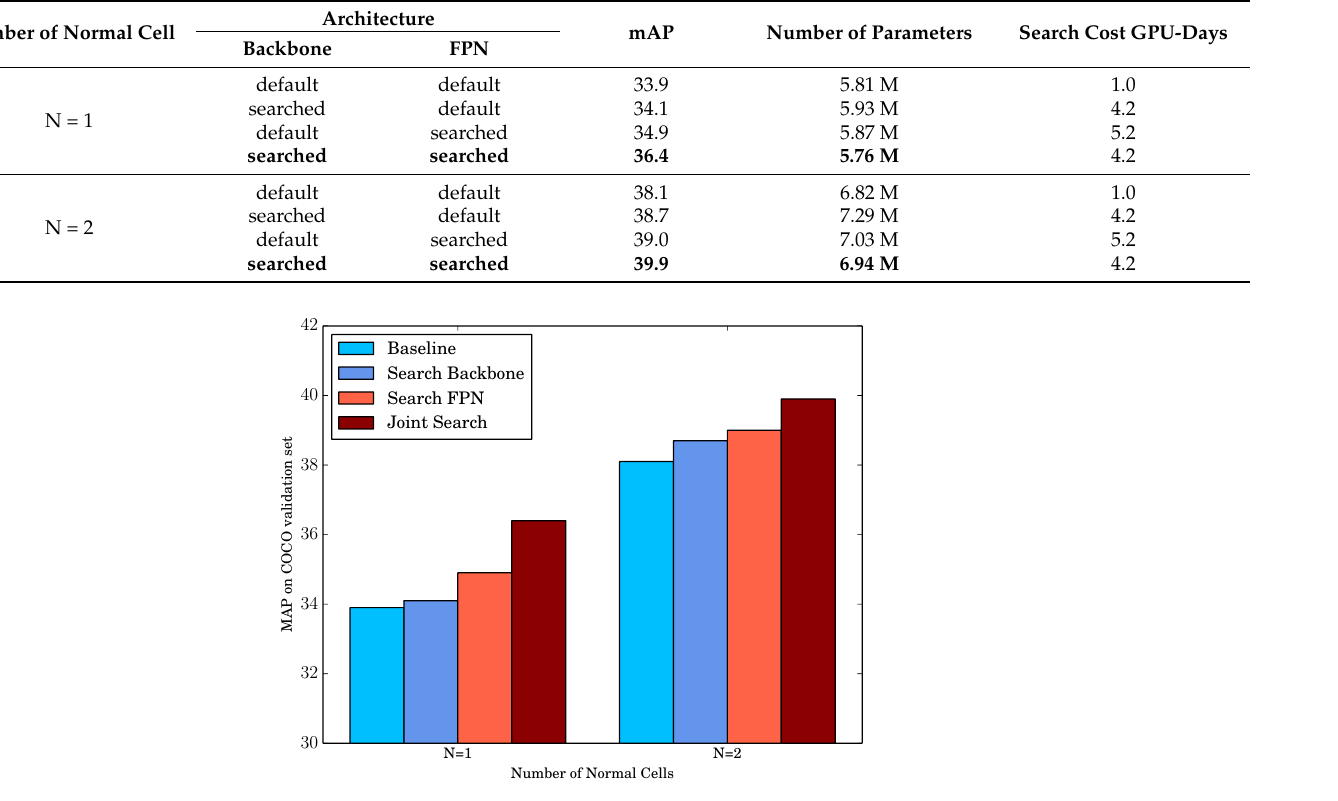
Figure 9. Performance of joint and independent search for backbone and FPN on MS-COCO validation set. Table 2. Comparison with prior works on the COCO test-dev. Different blocks indicate models with various inference speeds and prediction performance. ‘ (cid:63) ’: the unit of search cost is TPU-days, while the unit of other methods is